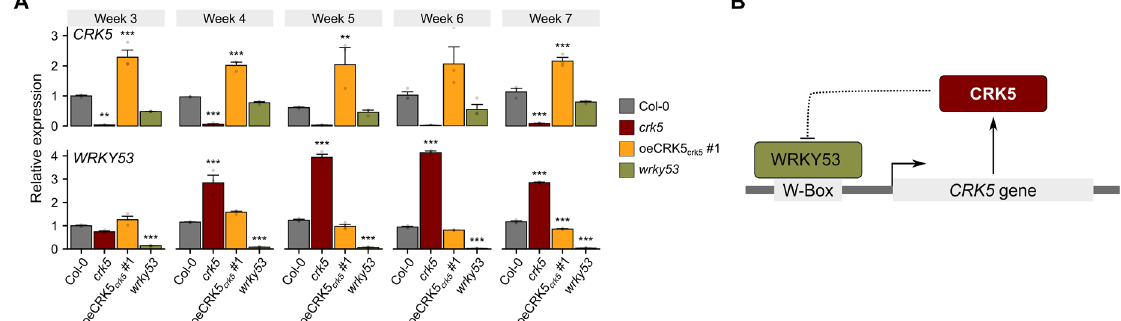
Figure 4. ( A ) qRT-PCR analysis of expression of WRKY53 and CRK5 in the analyzed genotypes. Data show relative expression normalized to the wild type and represent average values ± SD. Asterisks indicate a significant difference according to the t -test at level p < 0.001 (***), p < 0.01 (**). ( B ) Proposed model describing mutual CRK5 and WRKY53 relationship. We suggest the existence of a negative feedback loop between these